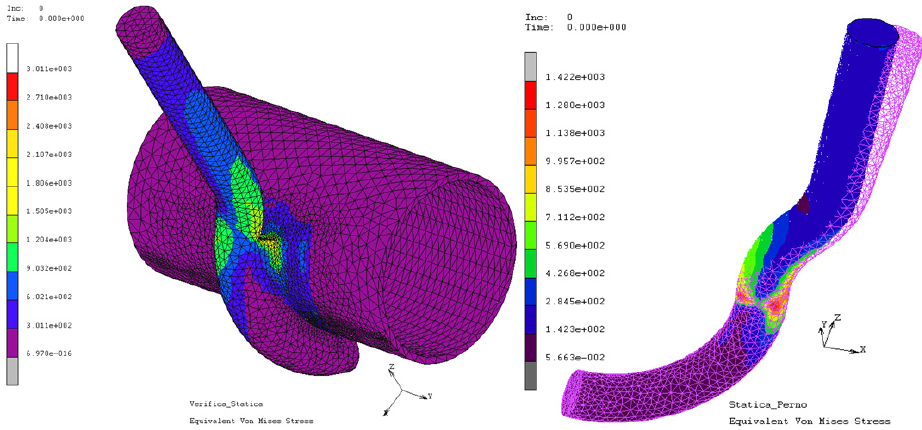
Figura 7: Simulazione della prova statica componente prima campionatura.